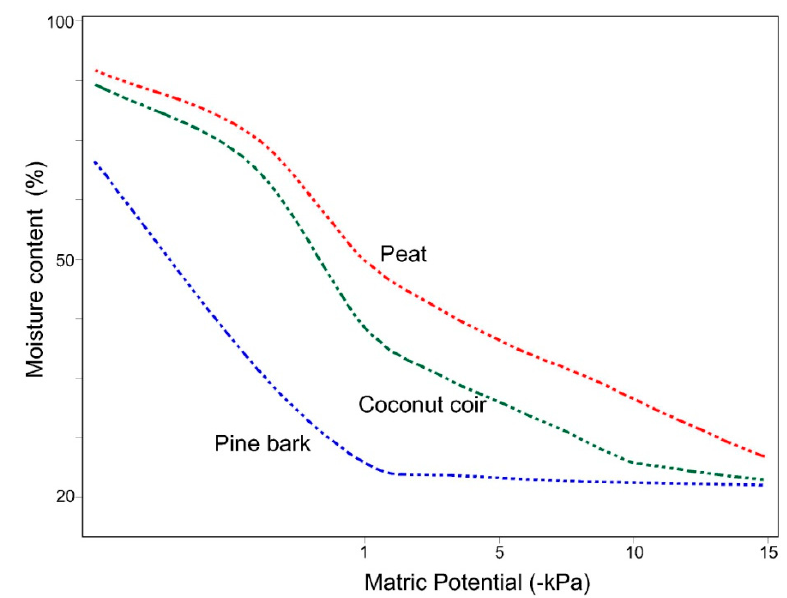
Figure 1. Moisture retention curves of peat, coconut coir and aged pine bark substrate components. Data adapted from [95].